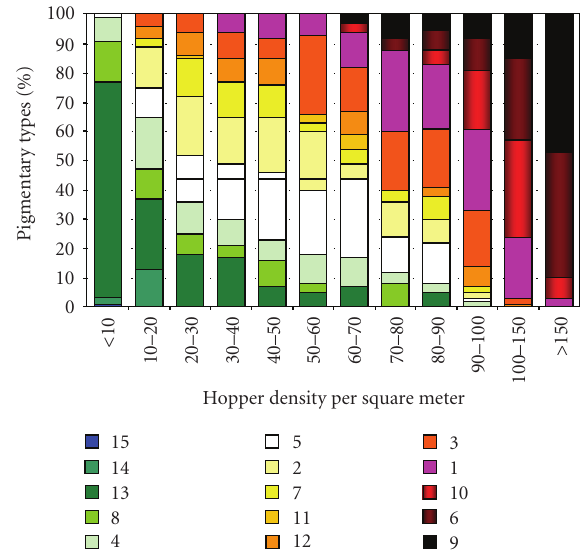
Figure 5: Relationship between the 15 color types and hopper densities. In X-coordinate: density classes; in ordinate: percentages of the various color types (1 to